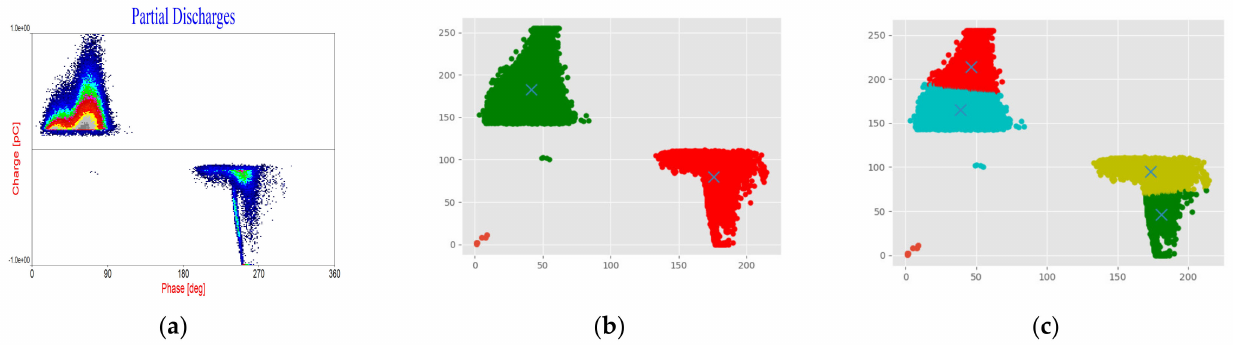
Figure 3. Clustering of partial discharge image ( a ) recorded in medium-voltage electrical machine insulation. Characteristic groups of discharges from positive and negative sinusoidal voltage periods extracted into K = 2 ( b ) and K = 4 ( c )